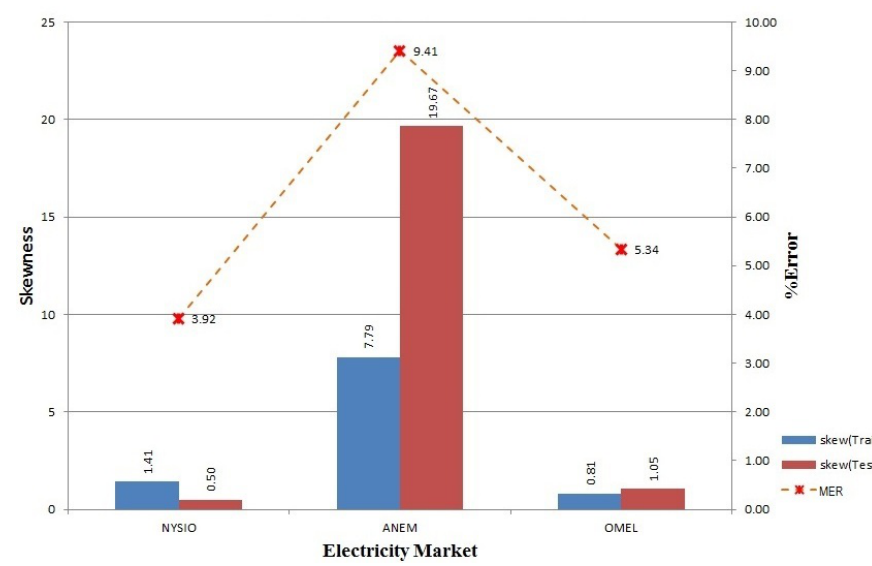
Figure 8. Hourly variance in training and testing data for ANEM (2008–2012).